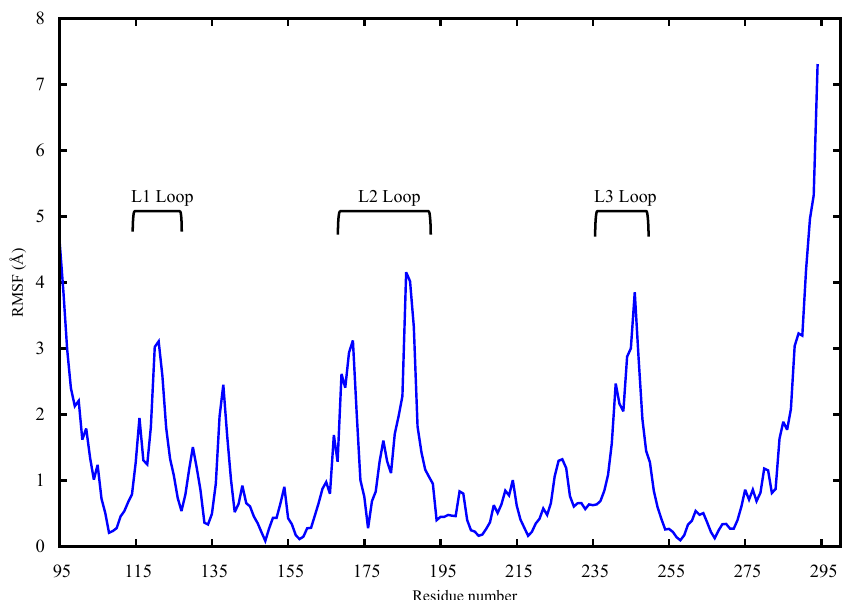
Figure 3. A plot of the RMSF of apo wt-p53 backbone calculated over all the MD trajectory filtered on the ewMCM. The loops L1, L2, L3 are labeled.